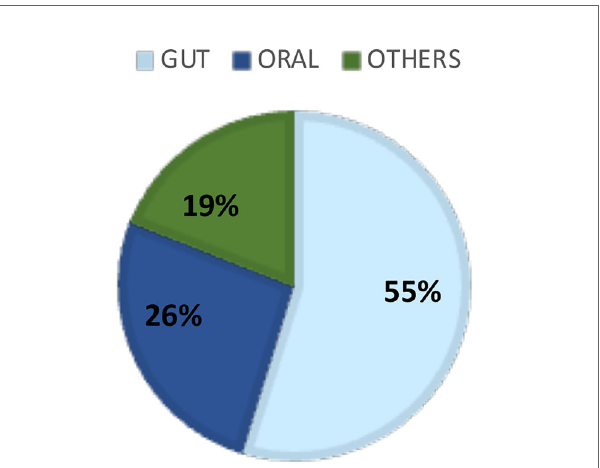
FIGURE 2 | Distribution of the literature papers of low abundant organisms by sample ’ s